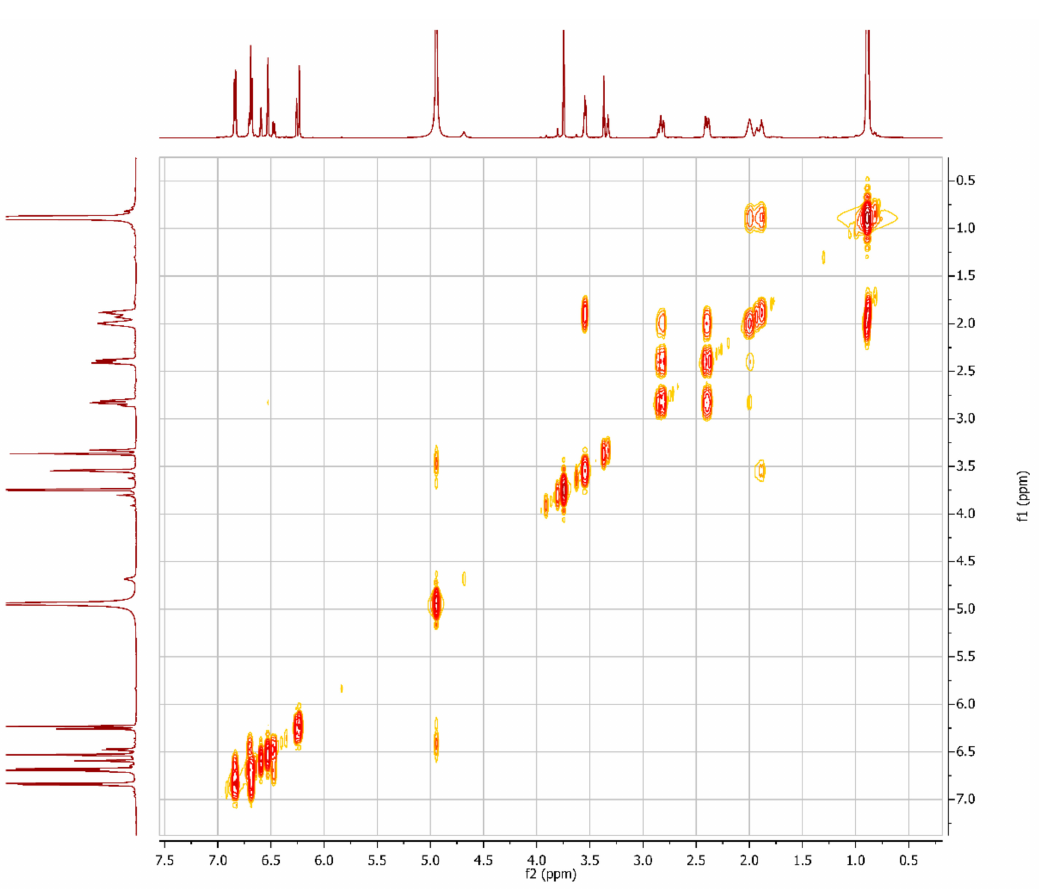
Figure A4. 1H-1H COSY NMR (CD3OD, 600 MHz) of 28 3 (cid:48) -demethoxy-6-O-demethylisoguaiacin ( 1 ) and norisoguaiacin ( 2 )